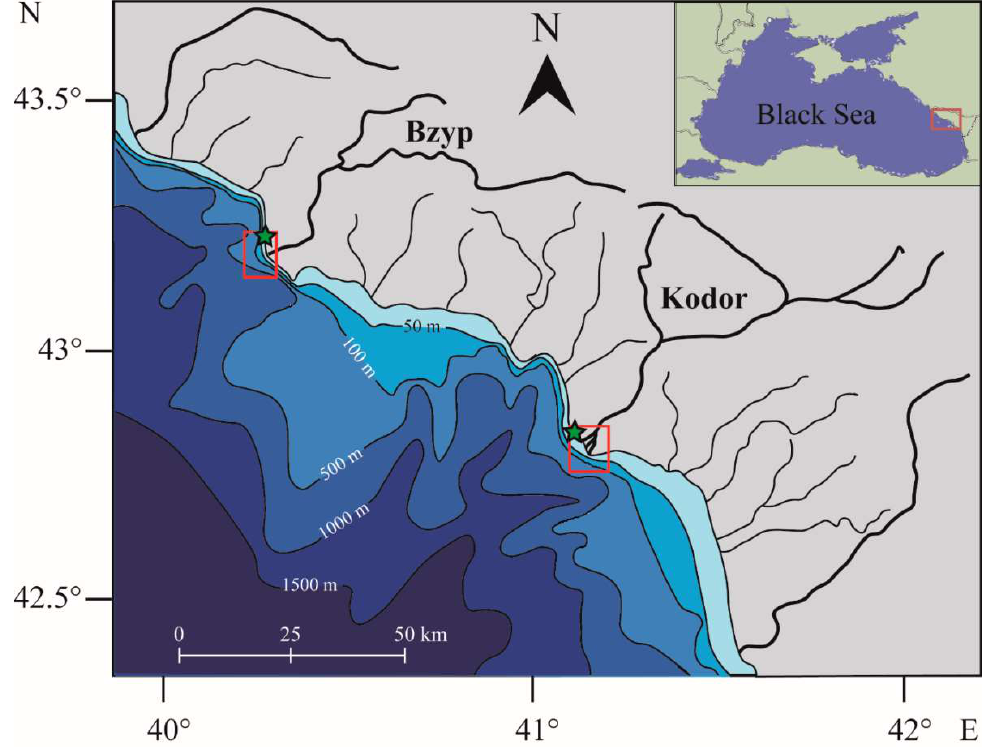
Figure 1. Study areas at the Bzyb and Kodor plumes at the eastern part of the Black Sea indicated by red boxes. Green stars indicate locations of meteorological stations. Table 1. Periods, areas of field work, and types of in situ measurements of oceanographic surveys. Period